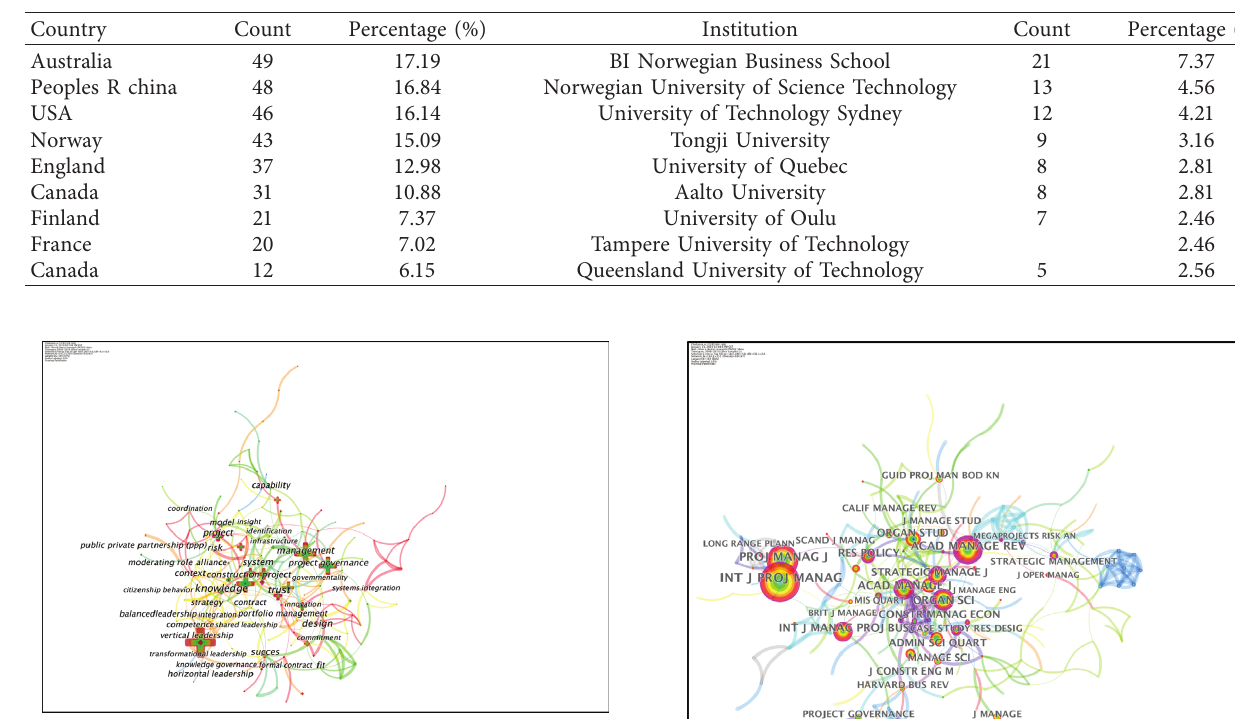
Figure 5: Network of co-occurring keywords in project governance research.